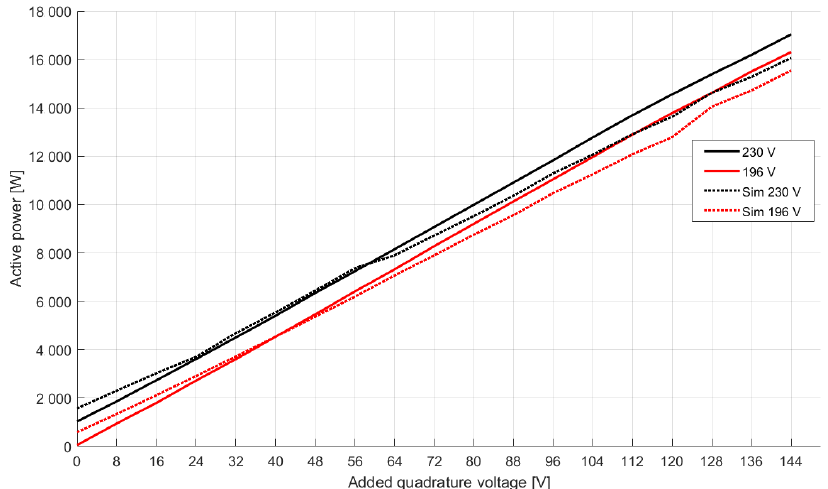
Figure 12. Comparison of transferred active power during laboratory tests (continuous line) and simulations (dotted lines).